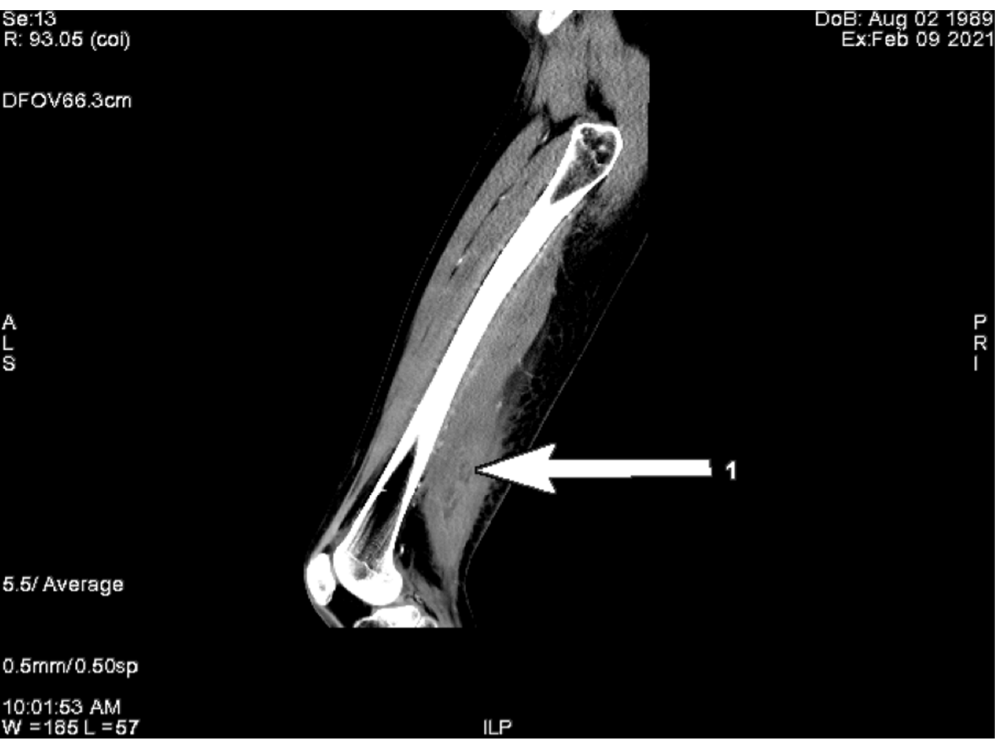
Figure 2. Right thigh CT after contrast administration revealed the fluid collection of degradation in posterior muscle compartment—arrow.